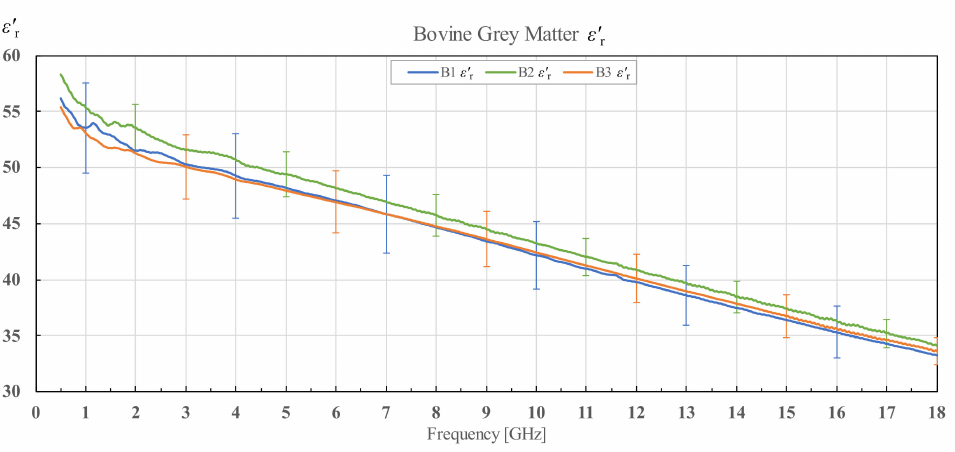
Figure 11. Real part of permittivity of bovine grey matter for brains B1, B2 and B3 with associated standard